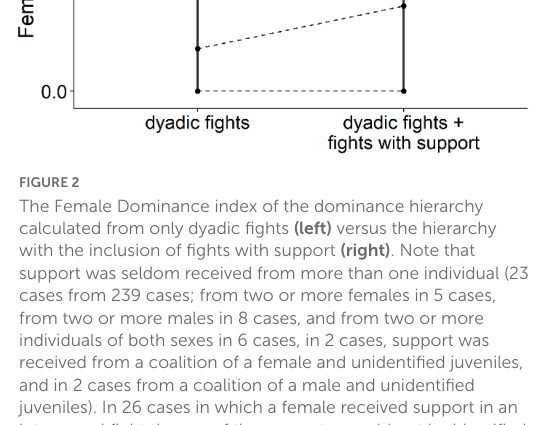
fights in which the female received support, this was provided mostly by a single adult female (111 times out of 239, 44% of cases), and less often by a single adult male (79 times, 33% of